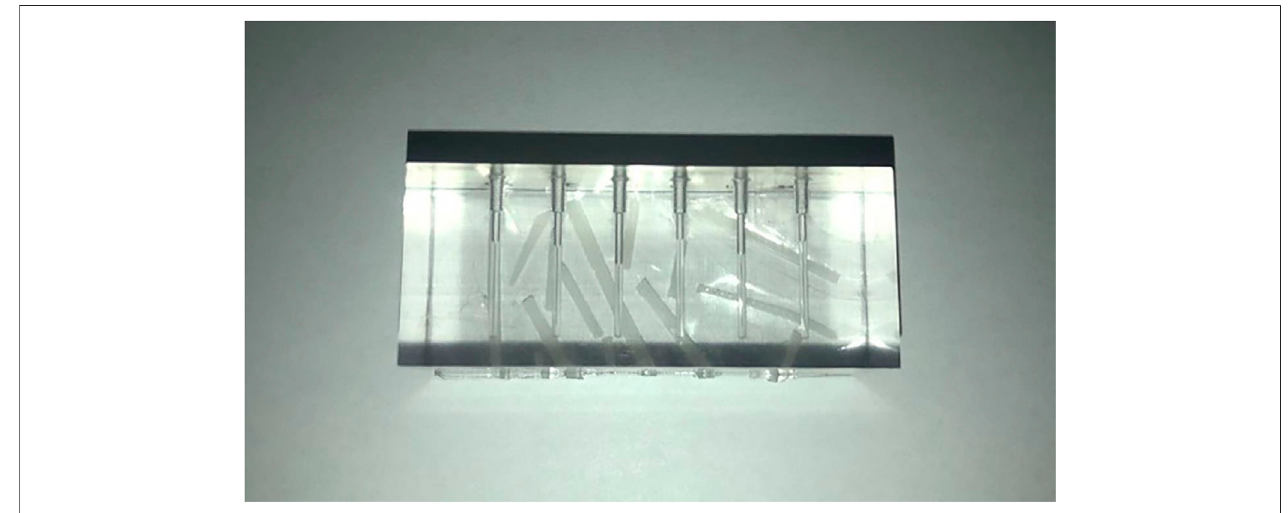
FIGURE 5 | Phantom used in the comparison experiment.